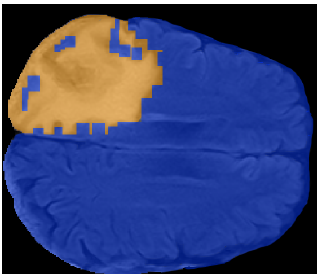
Figure 19. Examples of patches classification with fine-tuned VGG16: blue patches correspond to healthy tissue, orange patches correspond to ill tissue. The resolution of the segmentation is a consequence of rectangular shapes of the